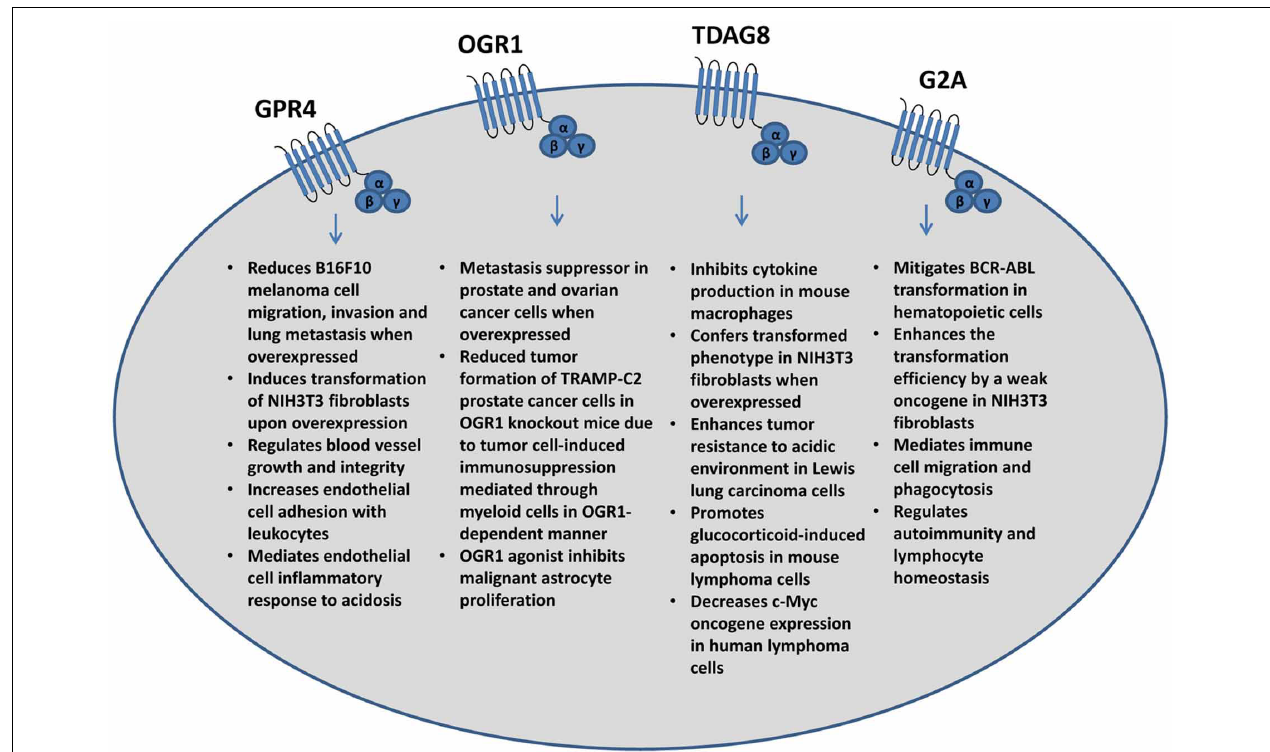
FIGURE 2 | Major effects of the pH-sensing G protein-coupled receptors on tumor cells and associated stromal cells and immune